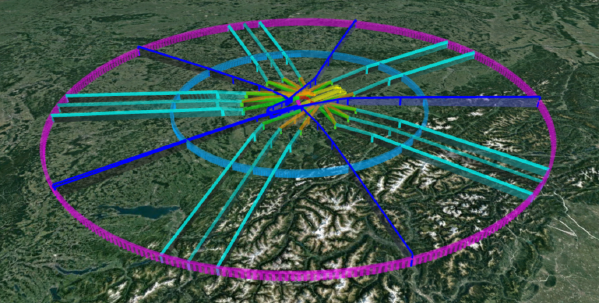
Figure 2. E-TMA: cyan = direct routes, purple = E-TMA boundaries, green = 4D paths, orange = 3D paths, blue = departure, red = direct-only merge points and routes.